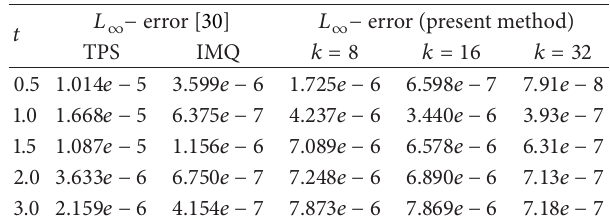
Table 3: Results for the value of 𝐿 ∞ error obtained by Haar-Sinc collocation method with 𝑛 = 3 and 𝑘 = 8,16, 32 for Example